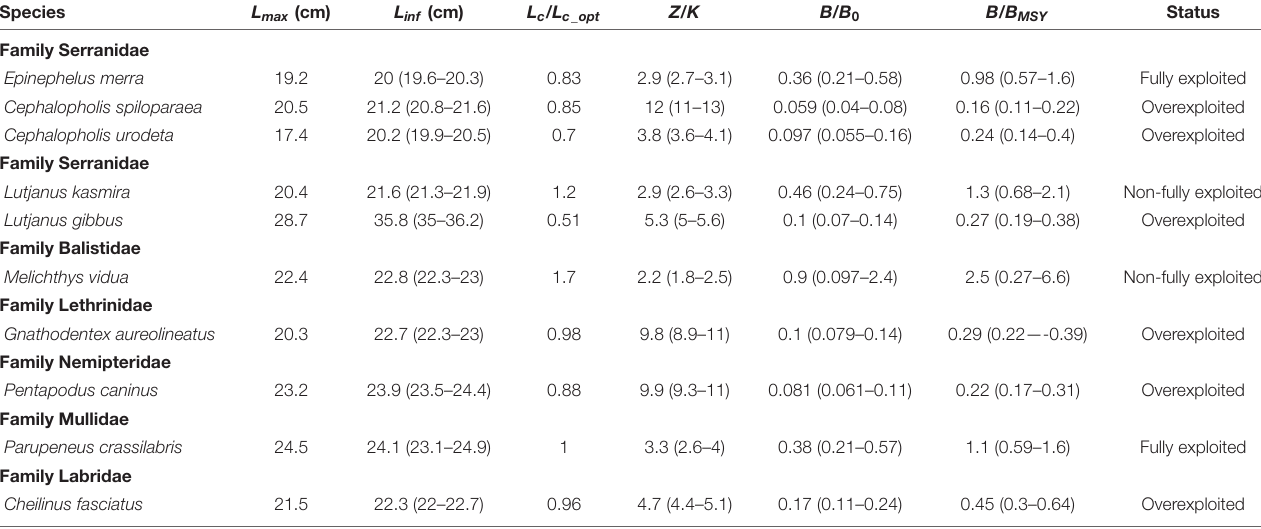
TABLE 3 | Summary of LBB outputs and status for the 10 coral reef fish species in Nansha Islands, South China Sea. Species L max (cm)